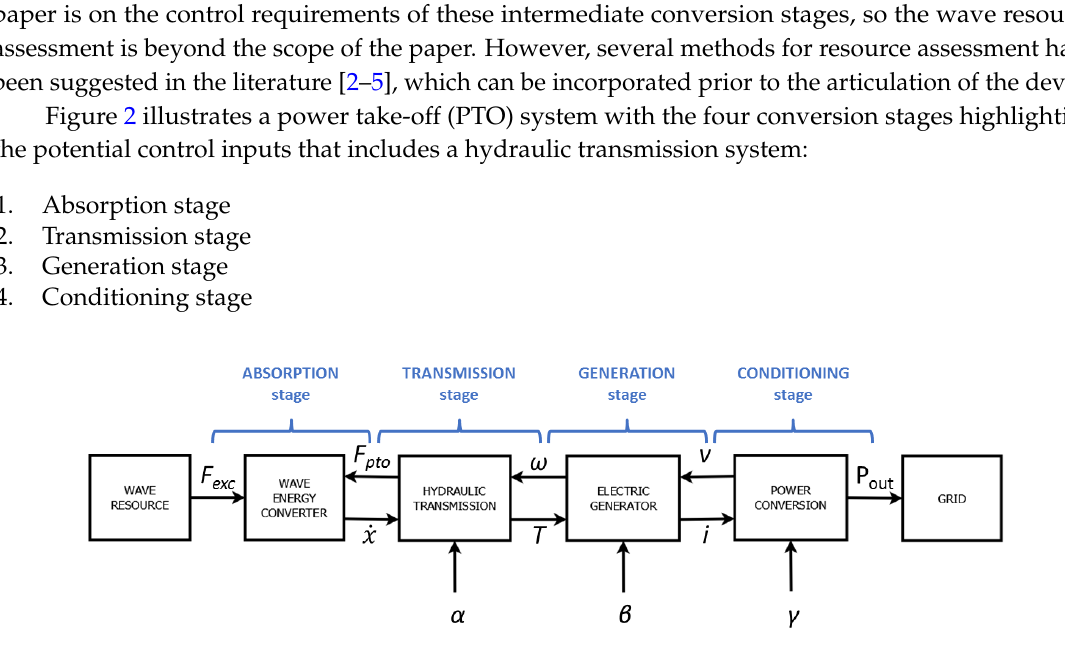
Figure 2. Diagram of a wave energy converter with a hydraulic power take-off, including potential control